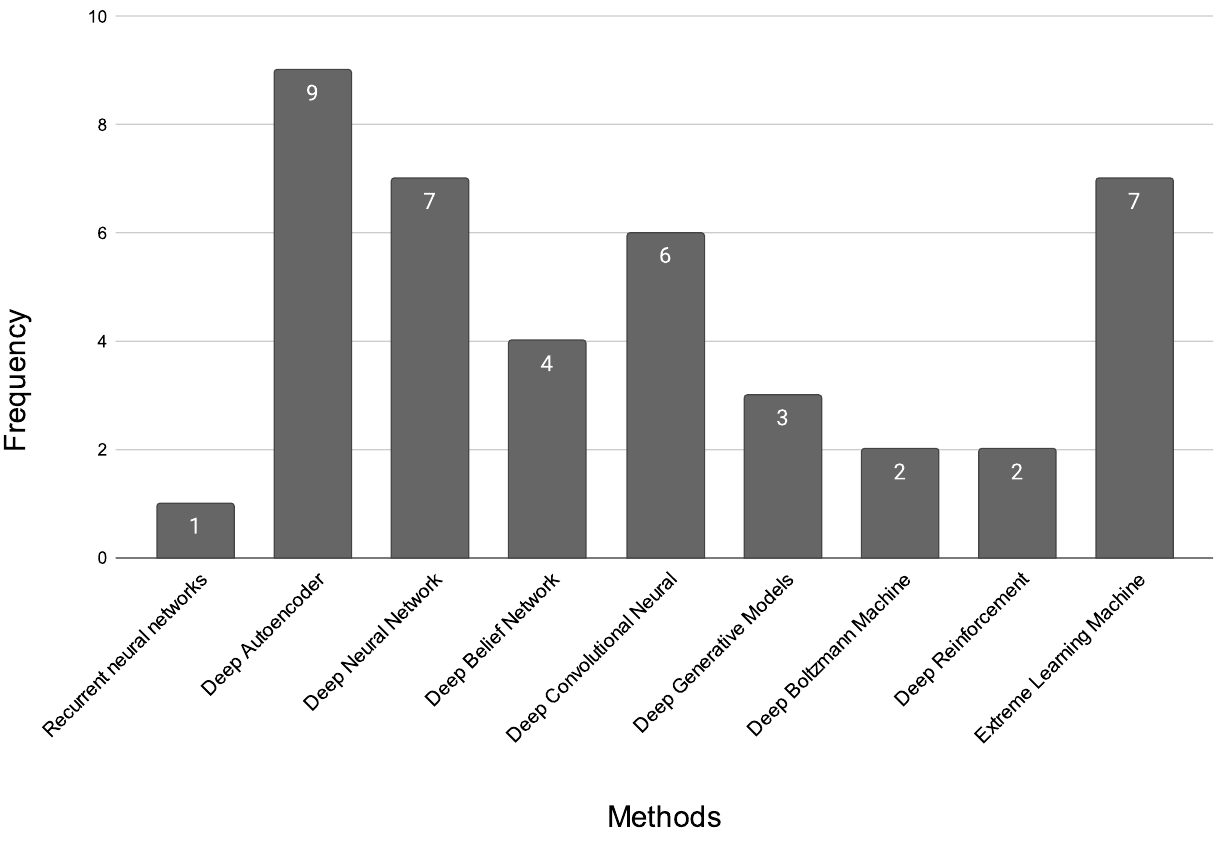
Figure 5. DL models vs. frequency of papers used in this work.